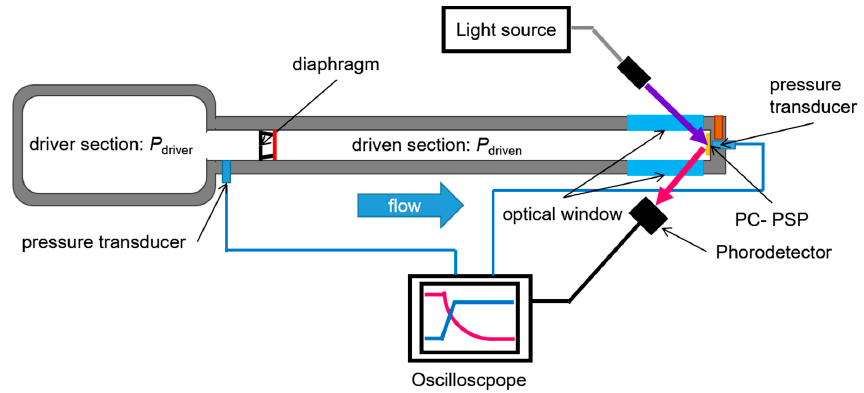
Figure 4. Schematic of unsteady-state calibration setup.